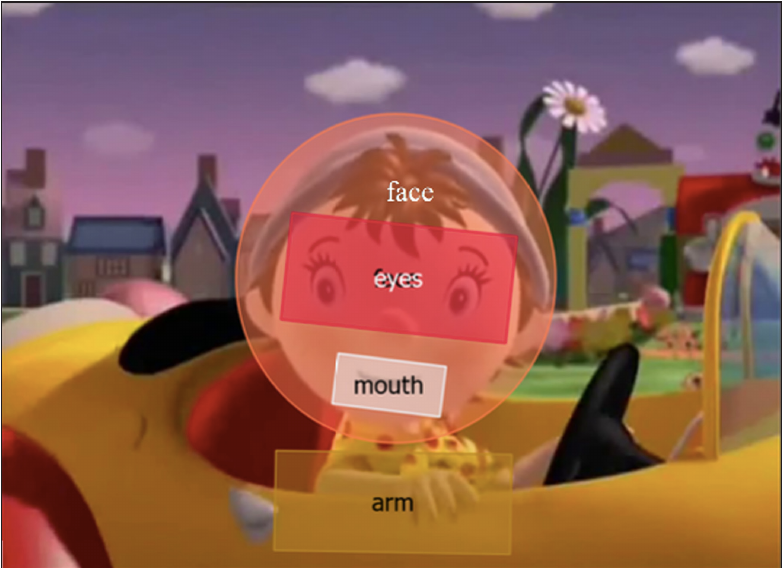
Figure 1: AOIs defined in the video: face, eyes, mouth, and